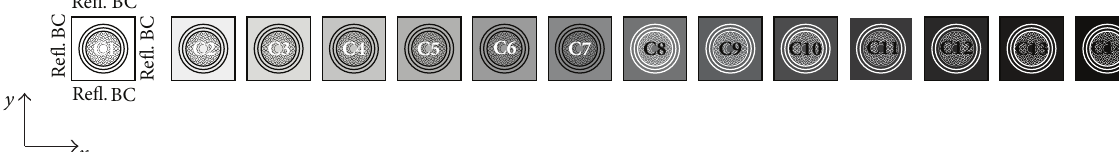
Figure 4: First step of the simulation strategy: 2D infinite lattice cell calculations.